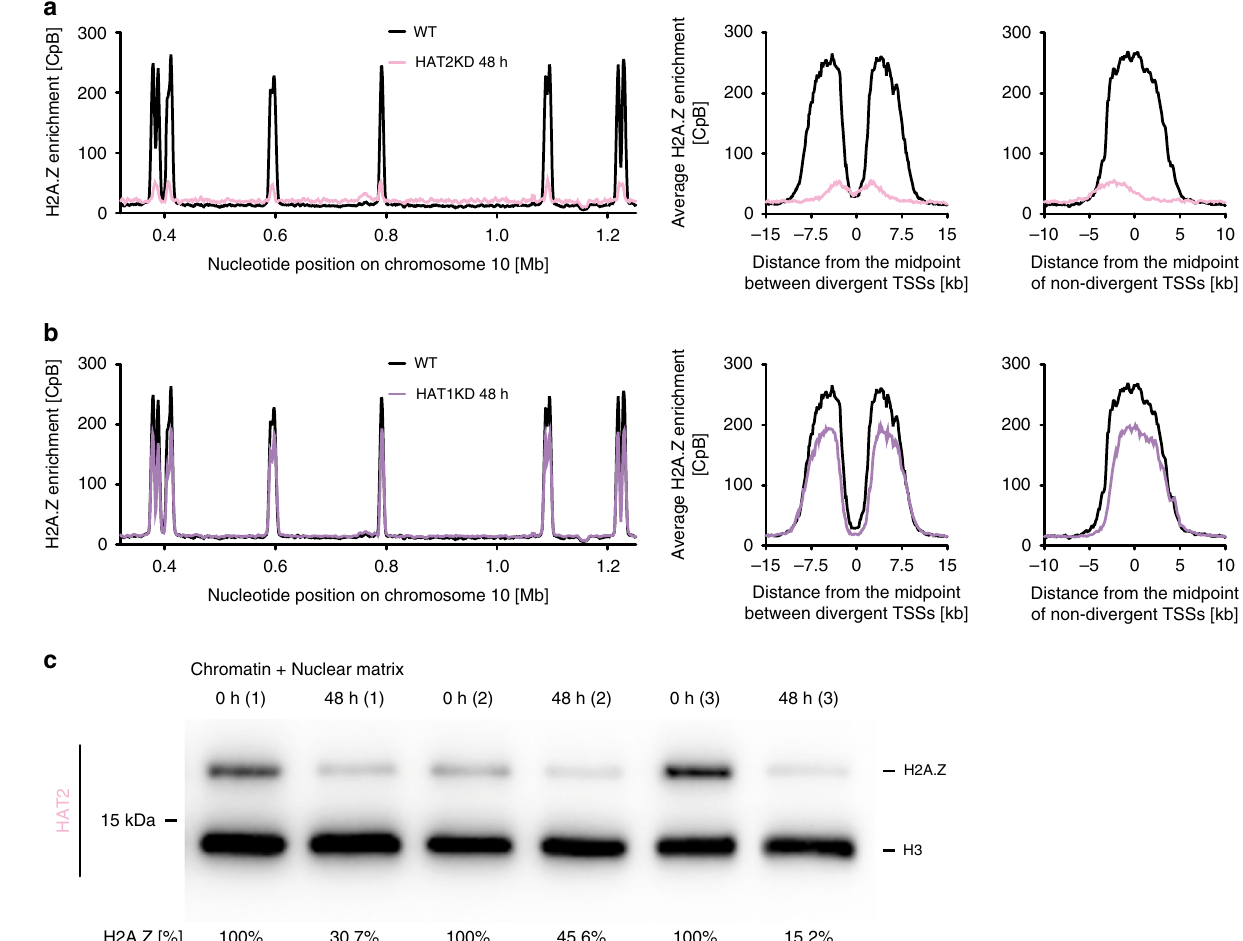
Fig. 6 HAT2 depletion leads to reduced H2A.Z deposition. a MNase-ChIP-seq data of histone variant H2A.Z before (black) and after 48 h HAT2 depletion (rose) are shown across a representative region of chromosome 10 (left panel) and averaged across divergent ( n = 37) and non-divergent ( n = 49) TSSs (right panel). The MNase-ChIP-seq data are normalized to the total number of reads and plotted as counts per billion reads [CpB]. Data from replicate 2 are shown, for all replicates see Supplementary Fig. 12. b MNase-ChIP-seq data of histone variant H2A.Z before (black) and after 48 h HAT1 depletion (purple) are shown across a representative region of chromosome 10 (left panel) and averaged across divergent ( n = 37) and non-divergent ( n = 49) TSSs (right panel). The ChIP-seq data are normalized to the total number of reads and plotted as counts per billion reads [CpB]. Data from replicate 1 are shown, for all replicates see Supplementary Fig. 13. c Western blot of chromatin-associated proteins extracted from 2T1 cells, which were depleted of HAT2 ( n = 3) for 0 h or 48 h. Loaded are the insoluble fractions, containing chromatin-bound and nuclear matrix material. H2A.Z [%] refers to the H2A.Z/H3 ratio. The H2A.Z/H3 ratio at 0 h HAT2-depletion was set to 100%. H2A.Z/H3 ratios were calculated by quantifying the H2A.Z and H3 signal over the background for each lane signal using ImageJ (see Supplementary Data 3). Source data are provided as a Source Data fi